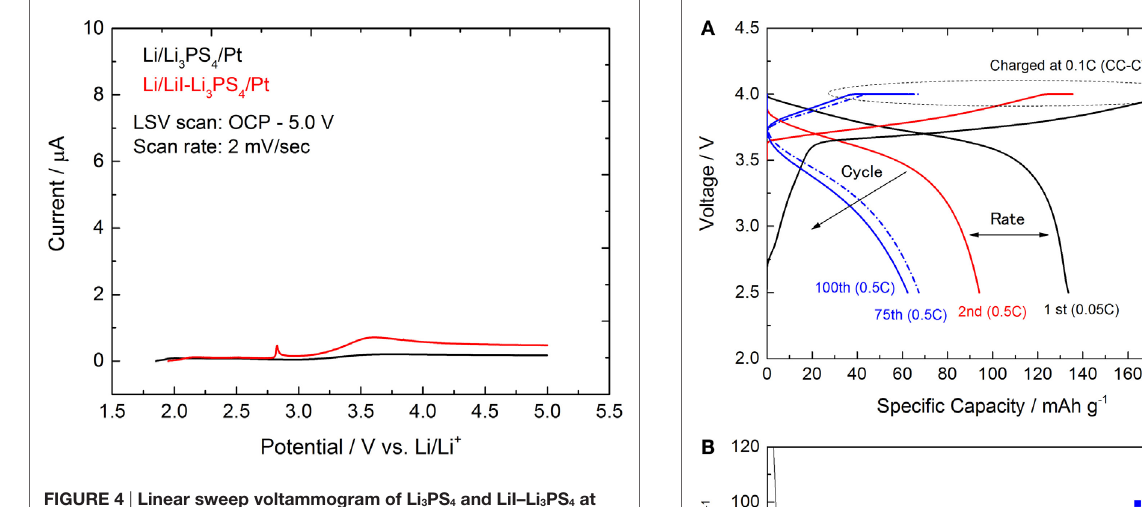
FigUre 4 | linear sweep voltammogram of li 3 Ps 4 and lii–li 3 Ps 4 at 25°c . WE: Pt, CE-RE: Li, scan rate: 2 mV s − 1